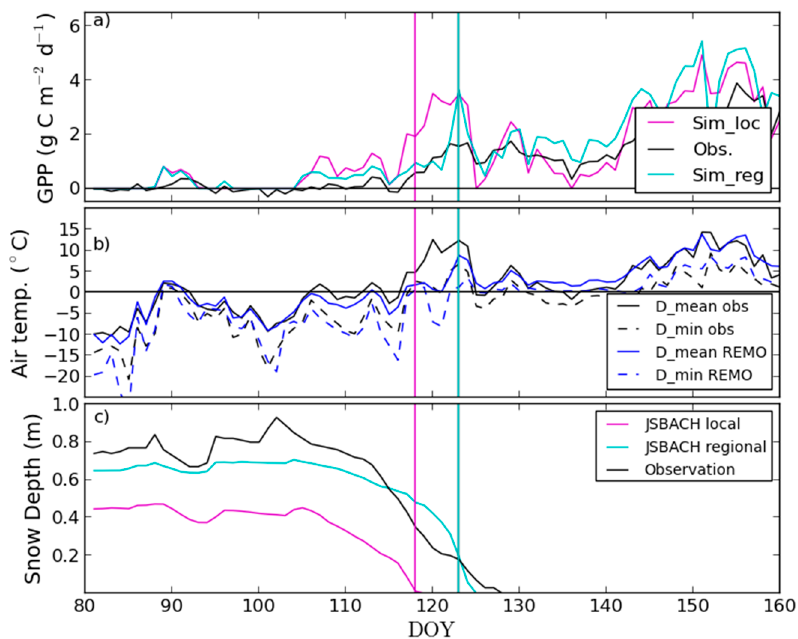
Figure 5. ( a – c ) Daily GPP, mean and minimum air temperature and snow depth for Sodankylä in spring 2008. Vertical lines indicate the start of season date: JSBACH local (magenta) refers to ENF_SOS mod,loc ; JSBACH regional (cyan) is ENF_SOS mod . Note that ENF_SOS EC occurred on the same day as ENF_SOS mod shown with cyan line.